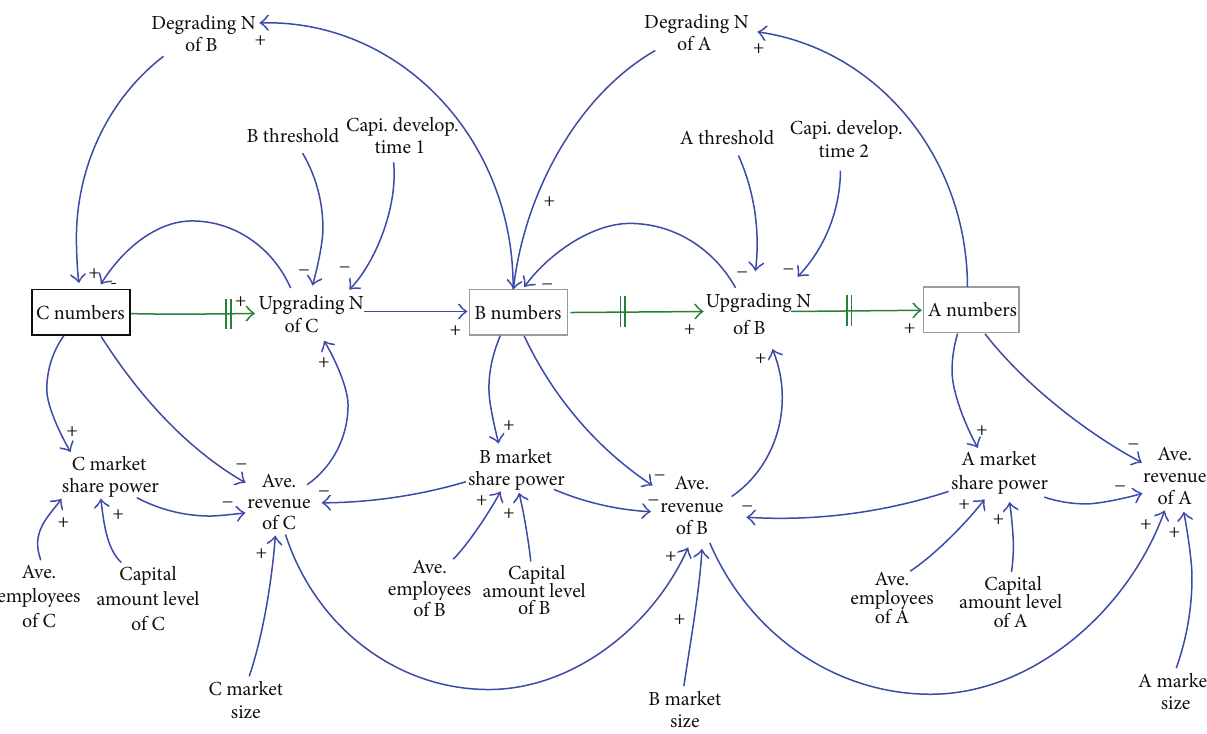
Figure 2: The casual loop diagram of the contractor rating